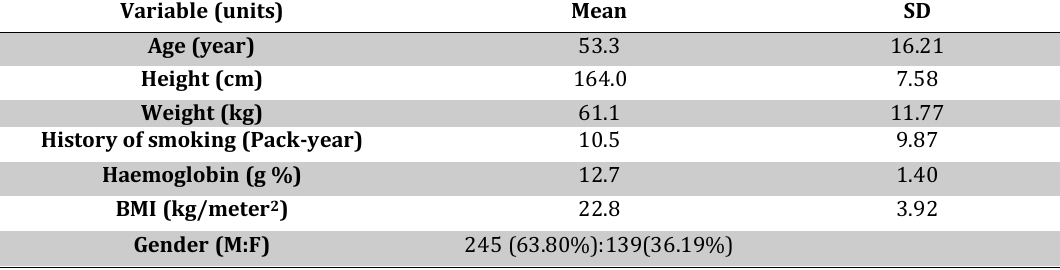
Table-1. Demographic parameters of study subjects (n=384)